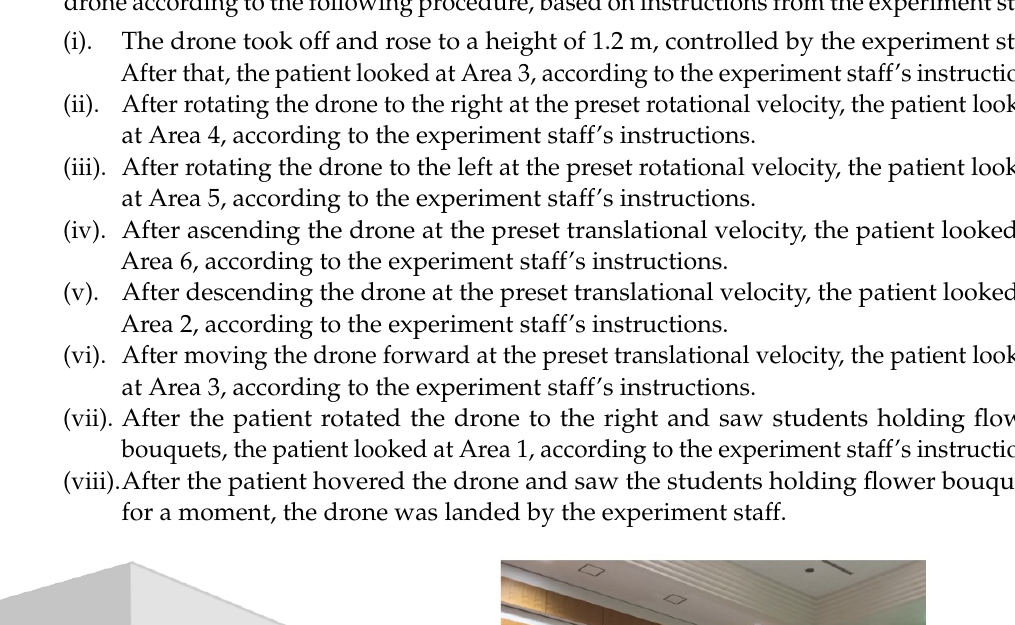
Figure 7. Control screen used in this experiment.